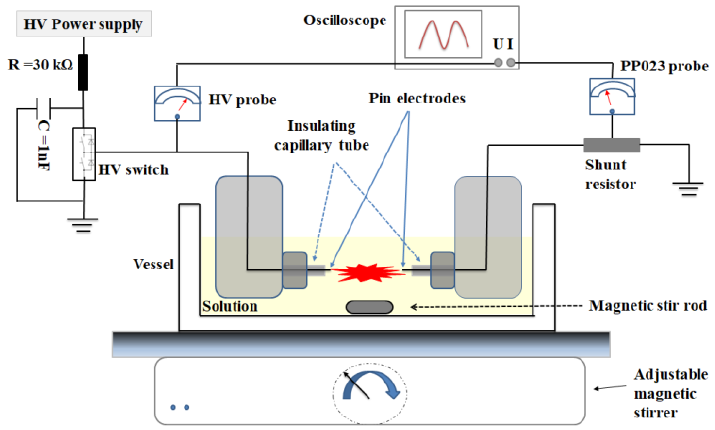
Figure 1. Experimental set-up (side view). The positive high-voltage pulse has a rise time equal to 30 ns and a variety of electrical parameters are chosen: the voltage range is between U = 2 kV and 12 kV and the pulse duration varies from ∆ t = 10 µ s to 1 ms. The repetition rate of the process is constant and equal to 50